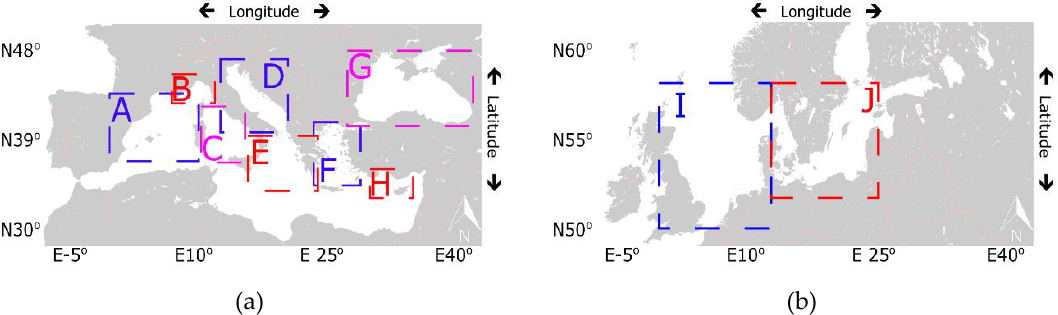
Figure 1. The geographical locations of the target areas considered in the European coastal environment; ( a ) Zones A, B, C, D, E, F, G, and H correspond to the southern and southeastern parts of Europe; ( b ) Zones I and J correspond to the north of Europe. Table 1. The geographical locations and the characteristics of the considered reference points; the depths are relative to the mean sea level Sea Depth Sea Point Lat. Long. Sea (m) Balearic